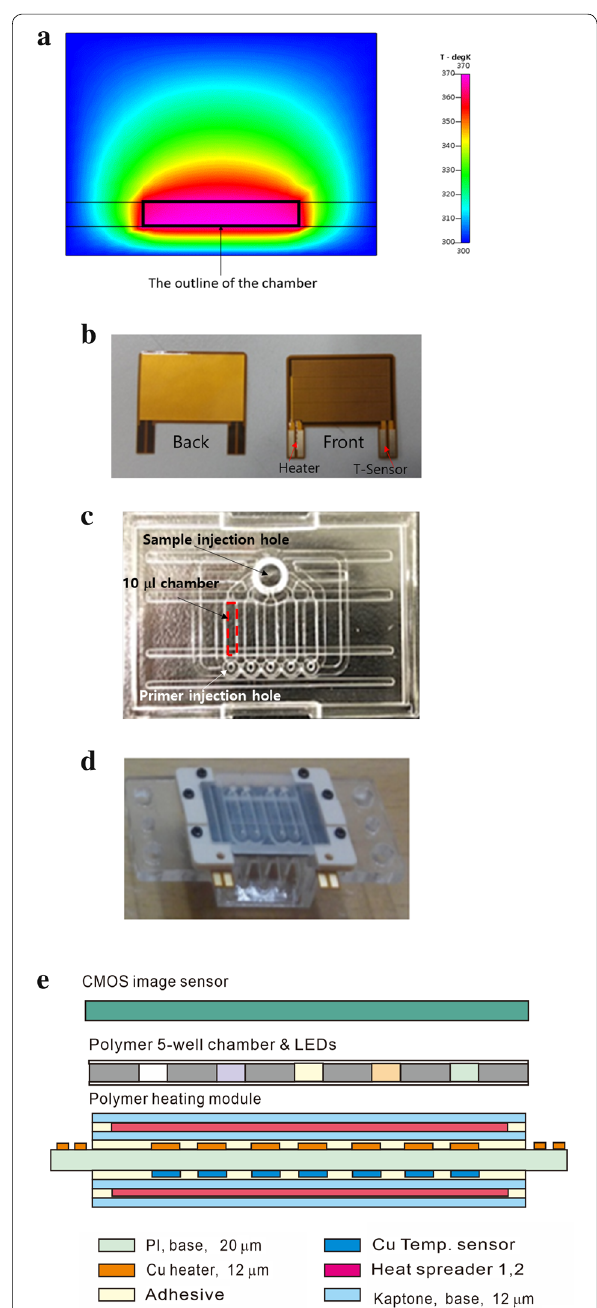
Fig. 1 a Simulated temperature distribution from the midst of the micro‑chamber at 97 °C using a simulator. b Pictures of heating modules on the polyimide substrate, c disposable polymer microfluidic chamber, and d a module combining the heating module and fluidic micro‑chamber with a manifold. e Simple schematic for the battery‑powered real‑time PCR device, showing how it combines key components and their